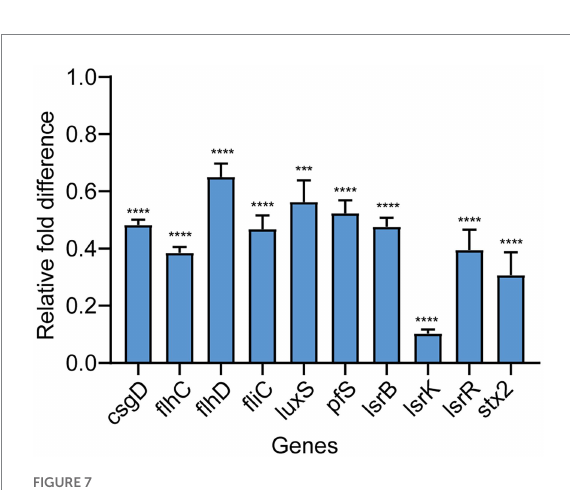
FIGURE 7 Effects of Ech on expression QS-regulated genes of E. coli . The qRT-PCR results showed significantly different nine genes ( csgD , flhC , flhD , fliC , luxS , pfs , lsrB , lsrK , lsrR , and stx2 ) compared with the control. Data represent means ± SD of three experiments conducted in